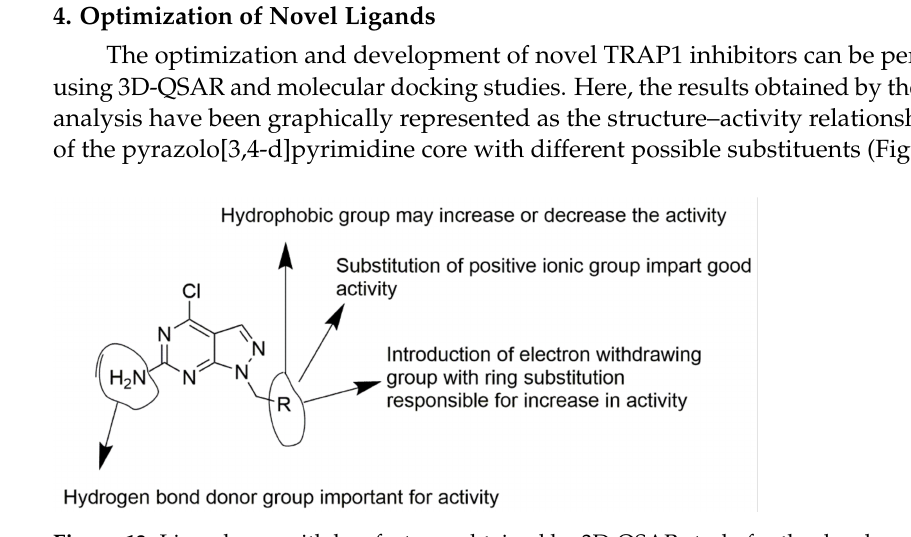
Figure 13. Ligand core with key features obtained by 3D-QSAR study for the development of novel